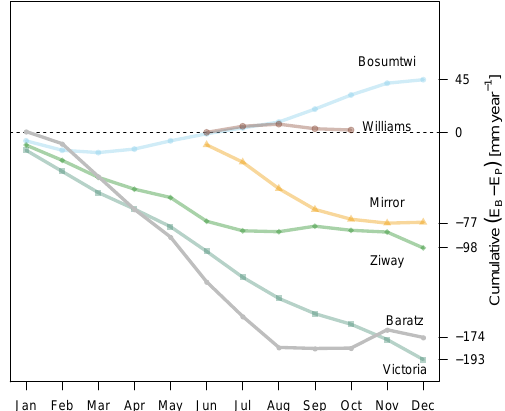
Figure 9. Monthly mean evaporation estimated using BREB and Penman’s equation for six lakes in different climatic zones.